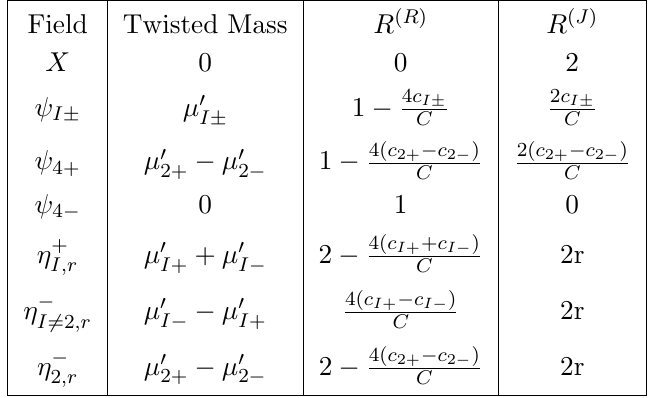
Table 7 . The spectrum on the worldsheet for a generalized quiver